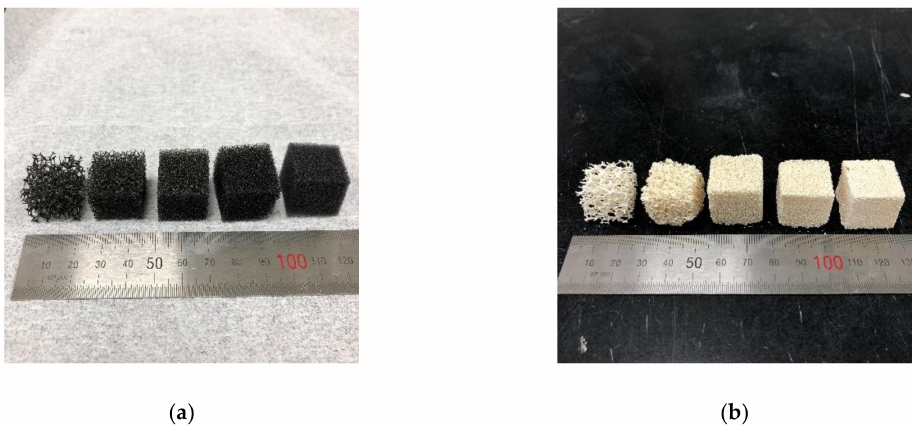
Figure 1. Optical images of ( a ) sacrificial polymer templates (in this study, polyurethane foam) with pore densities of 10, 25, 45, 60, and 80 pores per inch (PPI, from left to right), used in a typical replica method. ( b ) Reticulated porous diatomite–kaolin composite specimens with pore densities of 10, 25, 45, 60, and 80 PPI (from left to